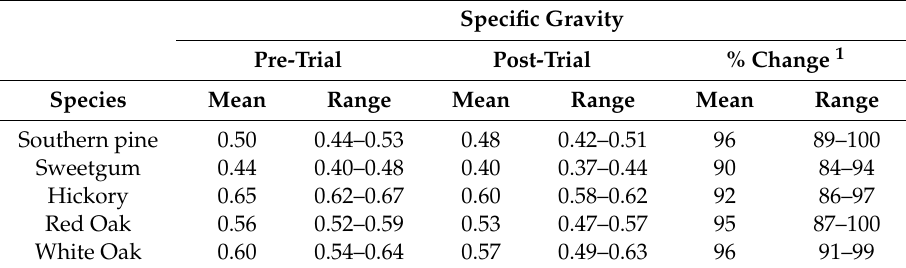
Table 4. Beginning and end specific gravity for the five species for successive wet-dry